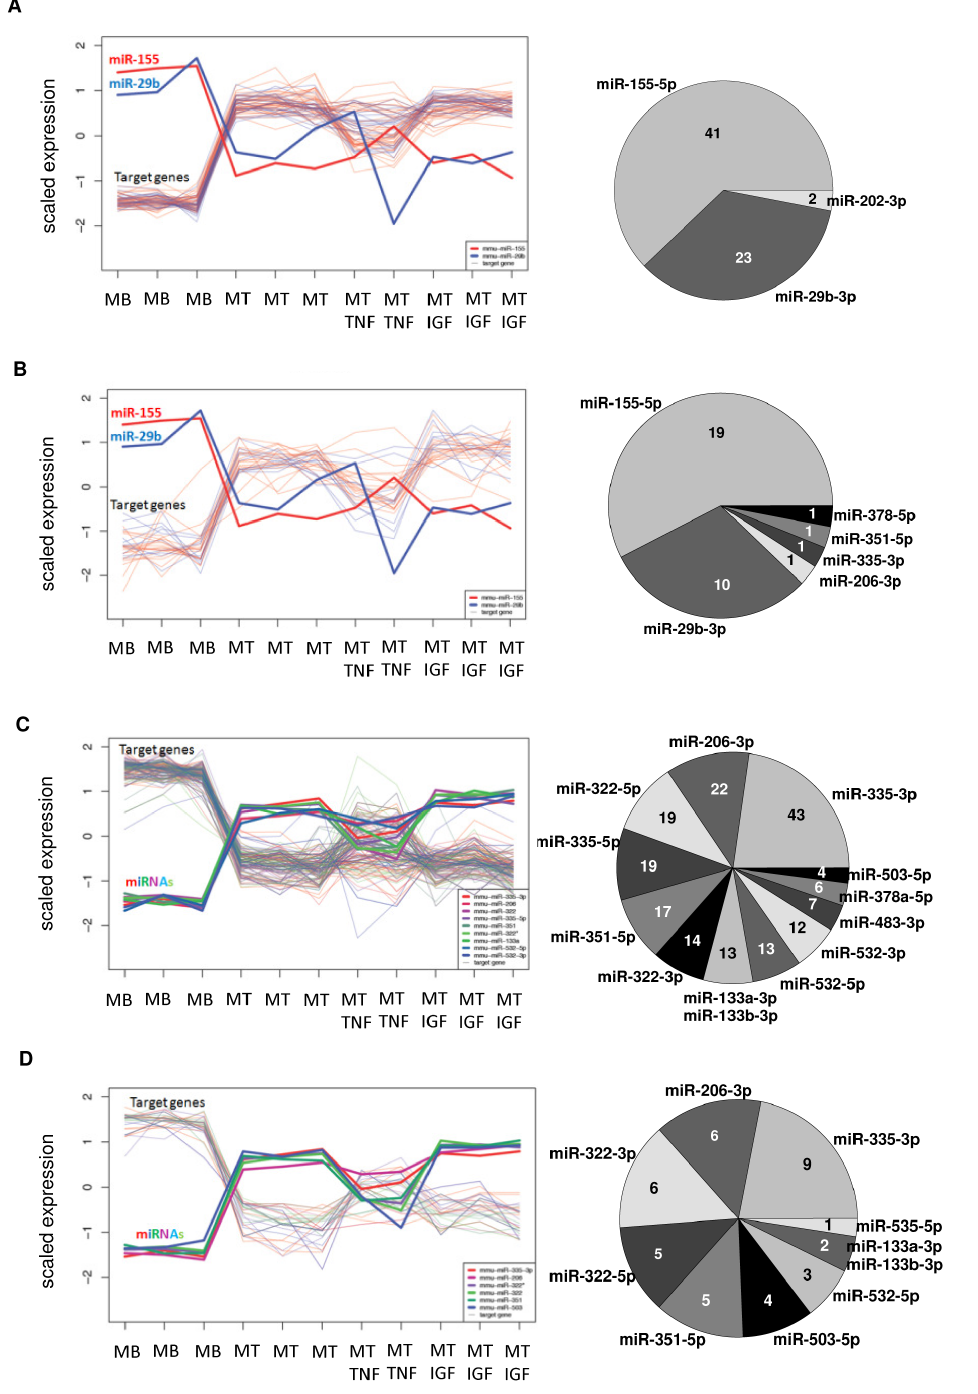
Fig 3. Gene expression clusters are targeted by distinct miRNA groups. Scaled expression (mean subtraction and division by standard deviation) levels of mRNA targets and their respective predicted and inversely associated miRNAs were depicted. Pie charts represent the relative number of mRNA targets per miRNA within the respective gene expression cluster. Absolute target numbers per miRNA within the gene expression cluster were given as well. Self- organizing tree algorithm clusters containing up-regulated genes in (A) early (24 h) or (B) late (72 h) myogenic differentiation, and genes which were (C) down-regulated in early or late myogenic differentiation, or (D) down-regulated in later (72 h) myoblast differentiation (72 h data not shown). A list of the outlined miRNA-mRNA relations was deposited in S4 Table.